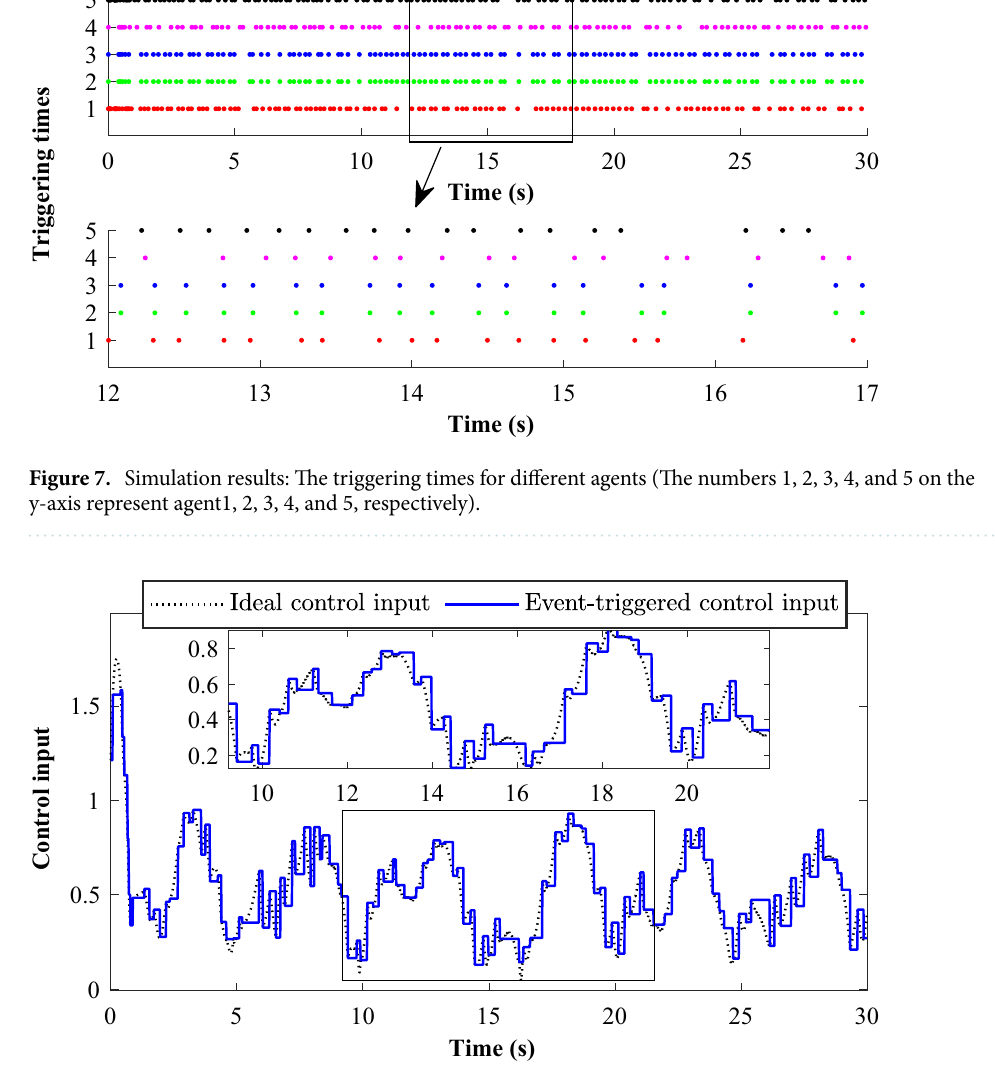
Figure 8. Simulation results: The event-triggered control input and the ideal control input of follower 3 (The event-triggered control input means ideal control input means